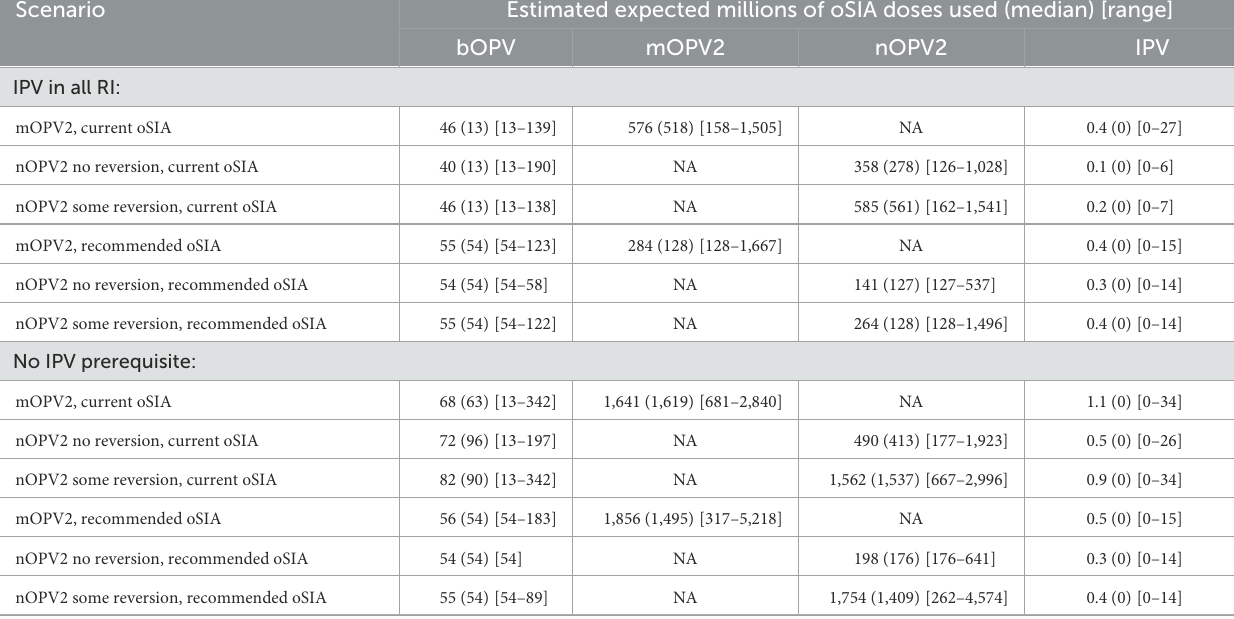
TABLE 5 Estimated expected value (median) and [range] of vaccine use for outbreak response in 100 stochastic iterations for 2016–2026 for the scenarios modeled. Scenario Estimated expected millions of oSIA doses used (median) [range] bOPV mOPV2 nOPV2